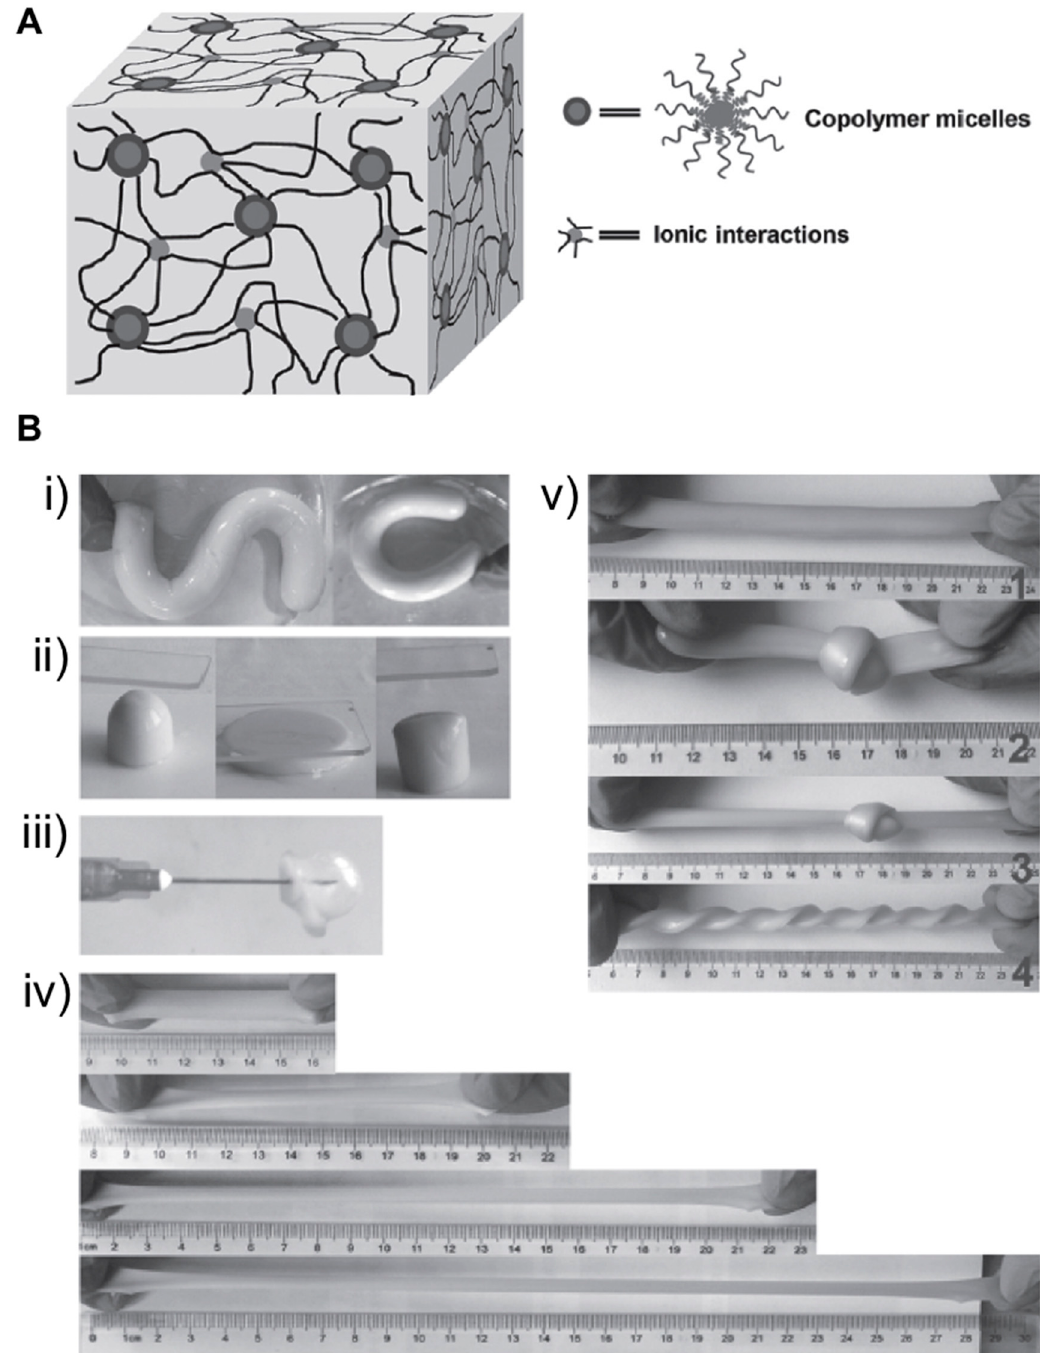
Figure 3. ( A ) Illustration of the double cross-linked (DC) hydrogel network. ( B ) Photographic images of the DC hydrogels: ( i ) An as-prepared hydrogel is bent into “S” shape and “C” shape. ( ii ) A DC hydrogel is pressed using a glass slide. From left to right, the images show the original, pressed, and released states, respectively. ( iii ) A balloon is made by blowing the DC hydrogel with a syringe. ( iv ) A DC hydrogel strip (water content 65%) is stretched to ~200%, ~370%, and ~540% of its original length. ( v ) From top to bottom, the images show a DC hydrogel strip, the hydrogel strip is knotted, the knotted hydrogel strip is stretched, and the hydrogel is unknotted and twisted. Adapted with permission from Reference [44]. Copyright 2017 Wiley-VCH.